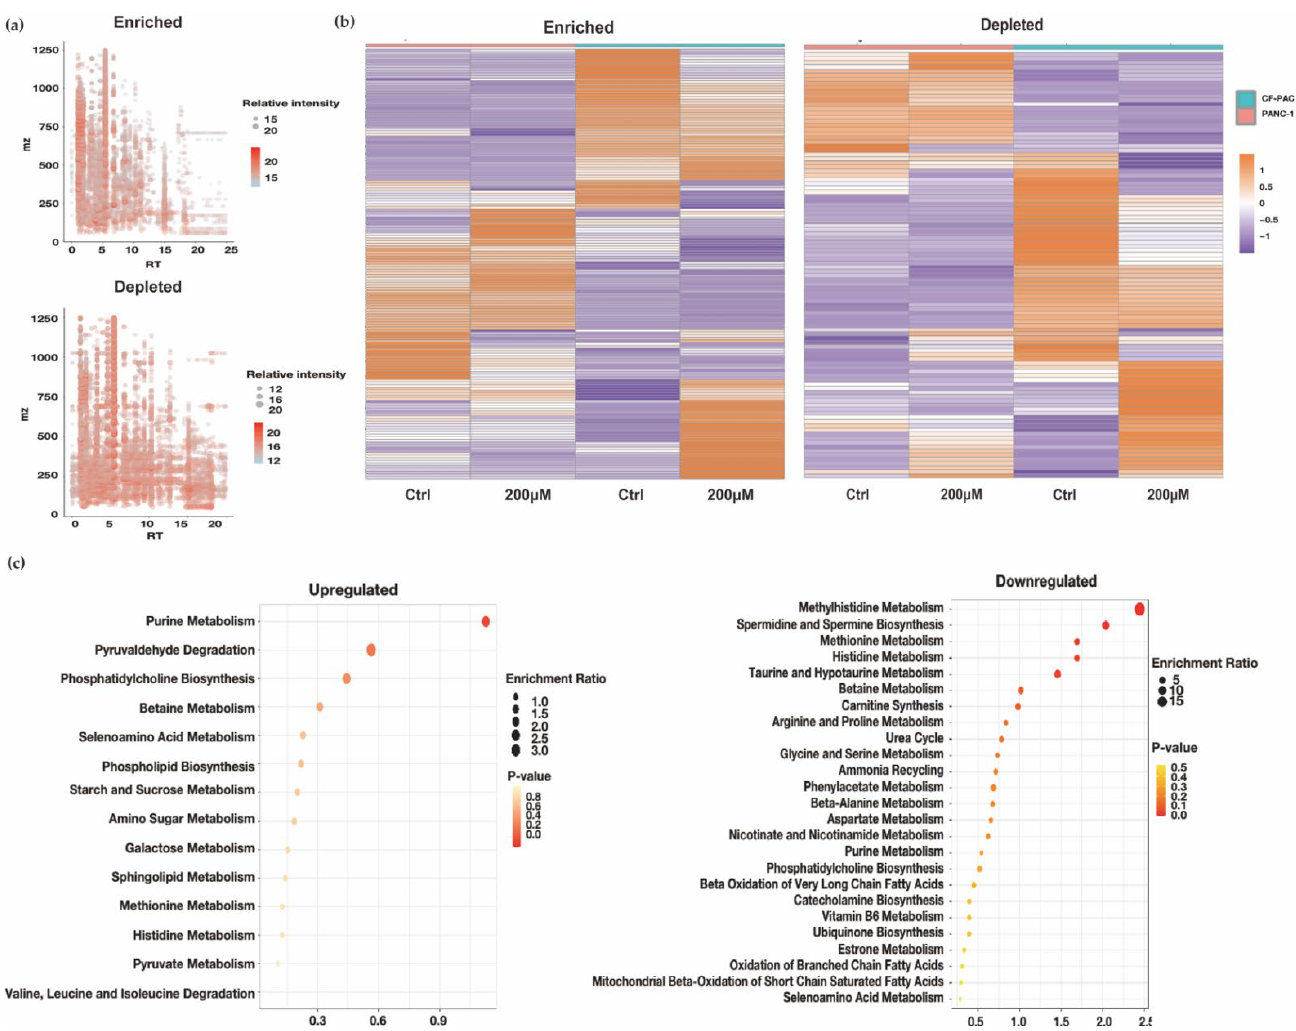
Figure 2. Analysis of metabolomic data of CoCl 2 treated PDAC cell lines. ( a ) Bubble chart of all metabolite molecules detected. The abscissa is the retention time, the ordinate is the mass-to-charge ratio, the size of the point is the relative abundance of metabolites. ( b ) Heatmap of metabolites in PANC-1 and CFPAC-1 cells affected by the use of CoCl 2 . ( c ) The SMPDB pathways enriched in upregulated and downregulated metabolites.